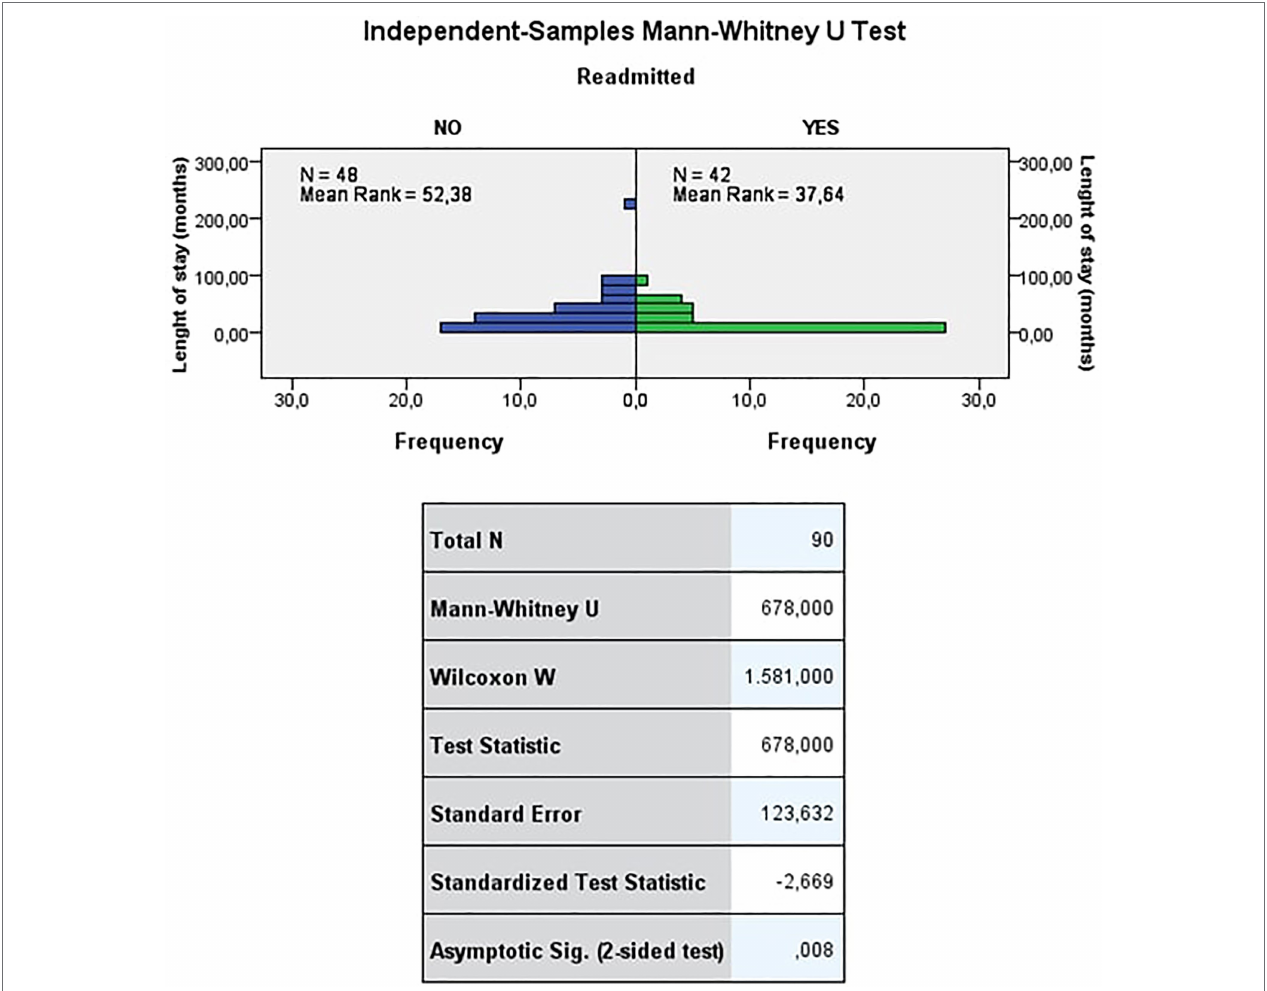
FIGURE 1 | Length of inpatient treatment (months). The Mann-Whitney test refuses the null hypothesis that the distribution of length of stay (months) is the same across the categories of readmitted at a significance level of 0.01 (value of p <0.01). Thus, being readmitted or not readmitted depends on the length of stay. Those who were not readmitted had, on average, significantly longer lengths of stay than those who were readmitted.